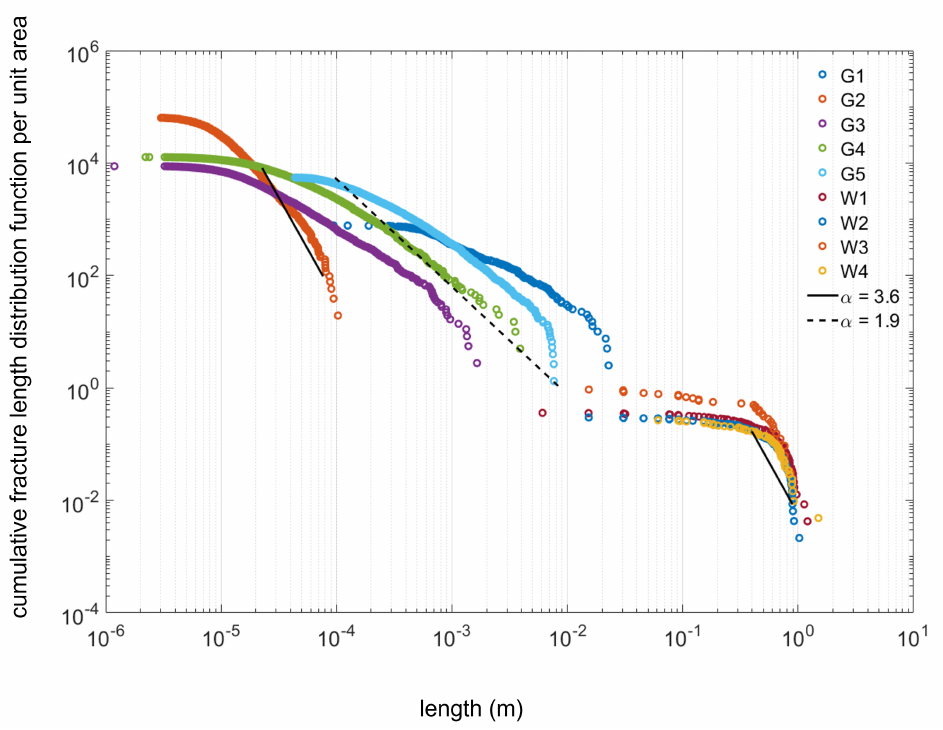
Figure 10. Multiscale fracture length distribution for the full set of rock image